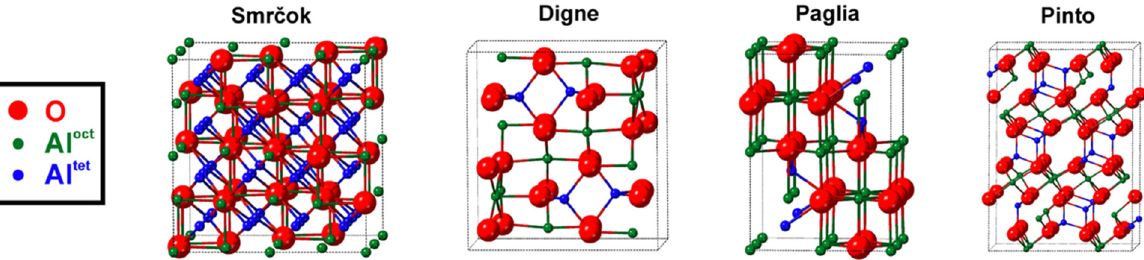
Figure 6. Schematic representations of γ -alumina bulk models. Unit cell boundaries are indicated by dotted black lines. Reprinted from Acta Materialia, Vol 182, Henry O. Ayoola, Stephen D. House, Cecile S. Bonifacio, Kim Kisslinger, Wissam